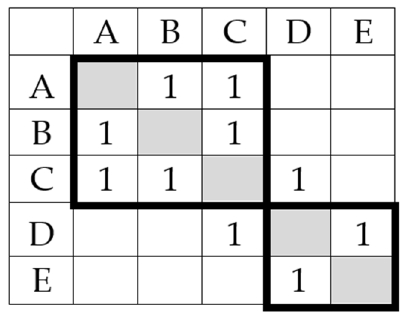
Figure 3. An example of design structure matrix.